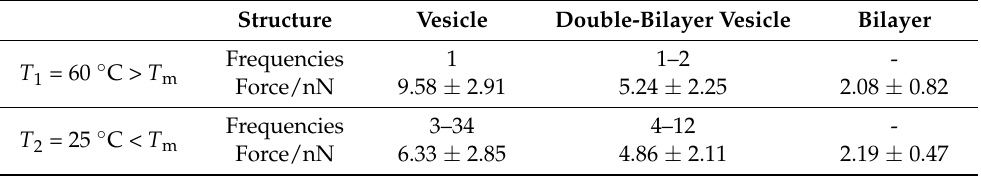
Table 2. Summary of bearing capacity on continuous loading and unloading for three structures of DPPC vesicles at two adsorbed temperatures. “Frequencies” is the maximal number of repeated loading and unloading iterations where vesicles (or double-bilayer vesicles) can return to their original shape after each approach. “Force” is the maximum breakthrough force for each structure (bilayer is not included). The statistics of curves at T 1 and T 2 come from 20 samples (vesicles), respectively.